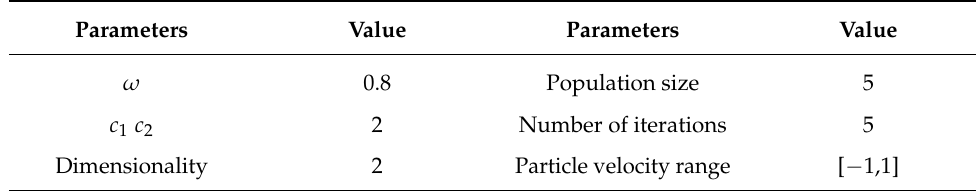
Table 5. PSO algorithm initialization